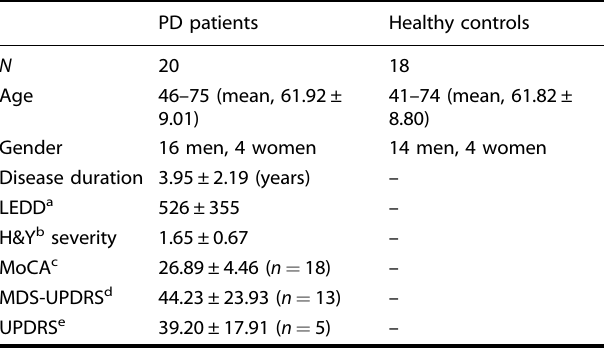
Table 1. Summary of Parkinson Disease (PD) patient and healthy control group demographics and clinical characteristics.